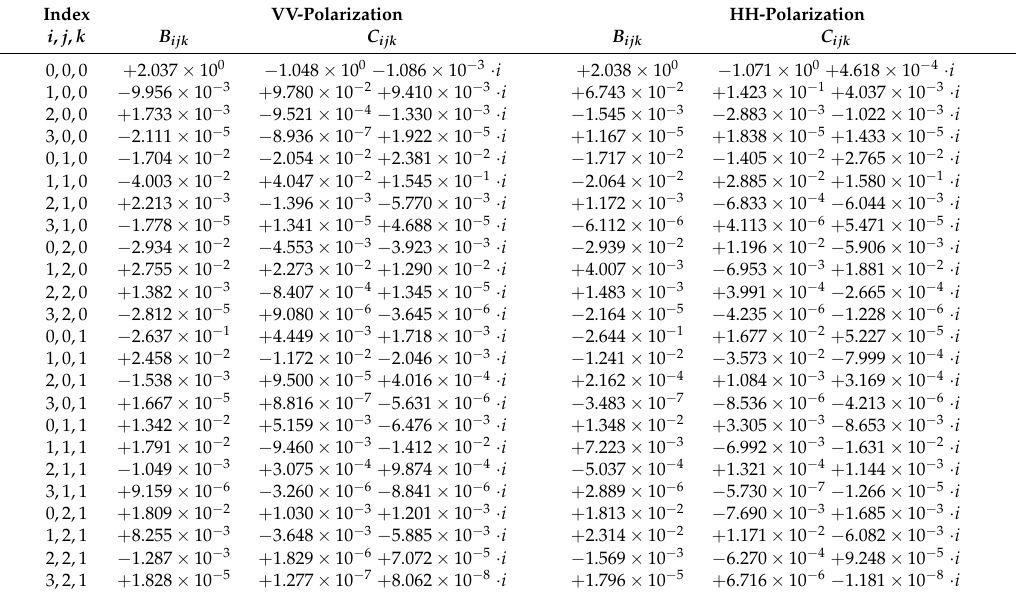
Table A2. Coefficients for the swell-MTF, M sw (the wind-sea MTF, M ws , with crosswind phase forced to 0 ◦